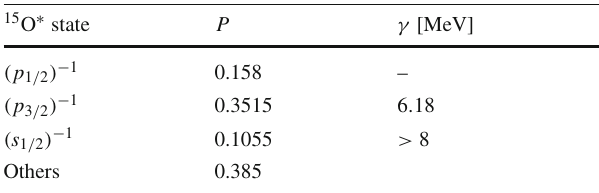
Table 3 Probabilities of 15 O ∗ state occurrences